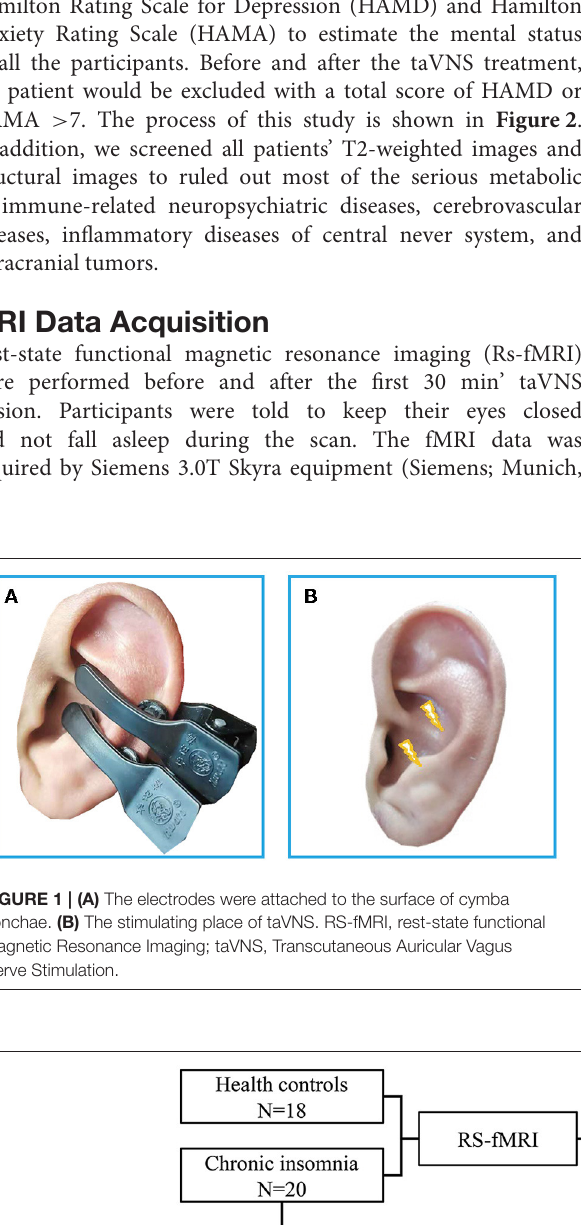
Frontiers in Neurology |